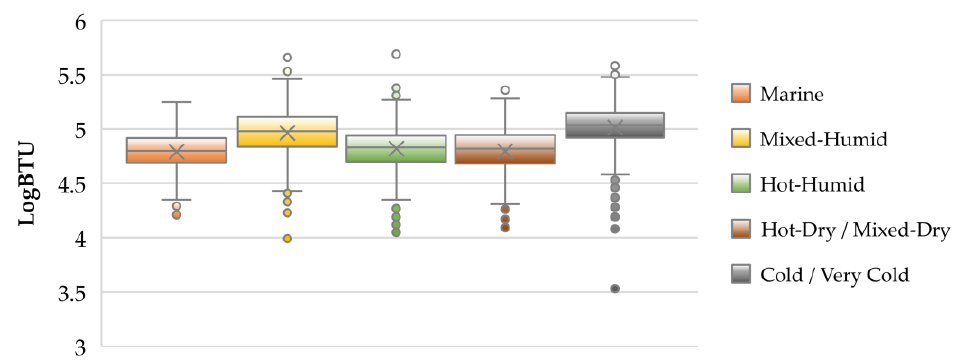
Figure 11. Box plot for LogBTU per climate region.